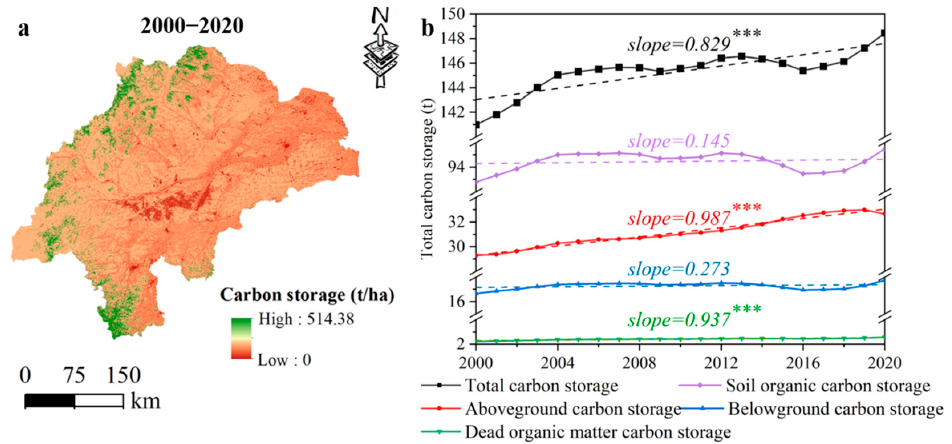
Figure 3. Spatiotemporal changes in carbon storage in the study area from 2000 to 2020. ( a ) The spatial distribution of the average carbon storage; ( b ) the changes in the carbon storages of the different carbon pools. Note: *** denotes significance at the 0.001 level.